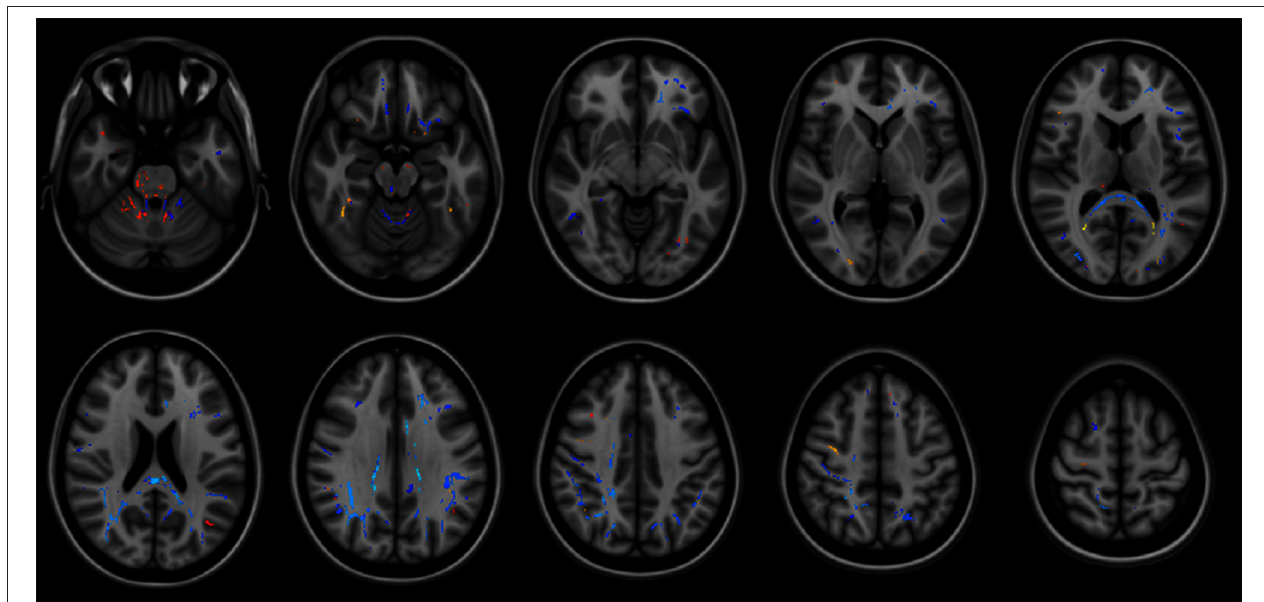
FIGURE 2 | Brain regions showing significant statistical differences between groups in structural connectivity as measured by fractional anisotropy (FA). Correction at p = 0.01. Findings in HC vs. FTD are shown in yellow-red. Findings in HC vs. EO-OABD are shown in blue. The background images on each panel are study-specific templates in MNI space. The right side of the images represents the left side of the brain. HC, healthy controls; FTD, frontotemporal dementia; EO-OABD, early-onset older-age bipolar disorder; MNI, Montreal Neurological Institute.